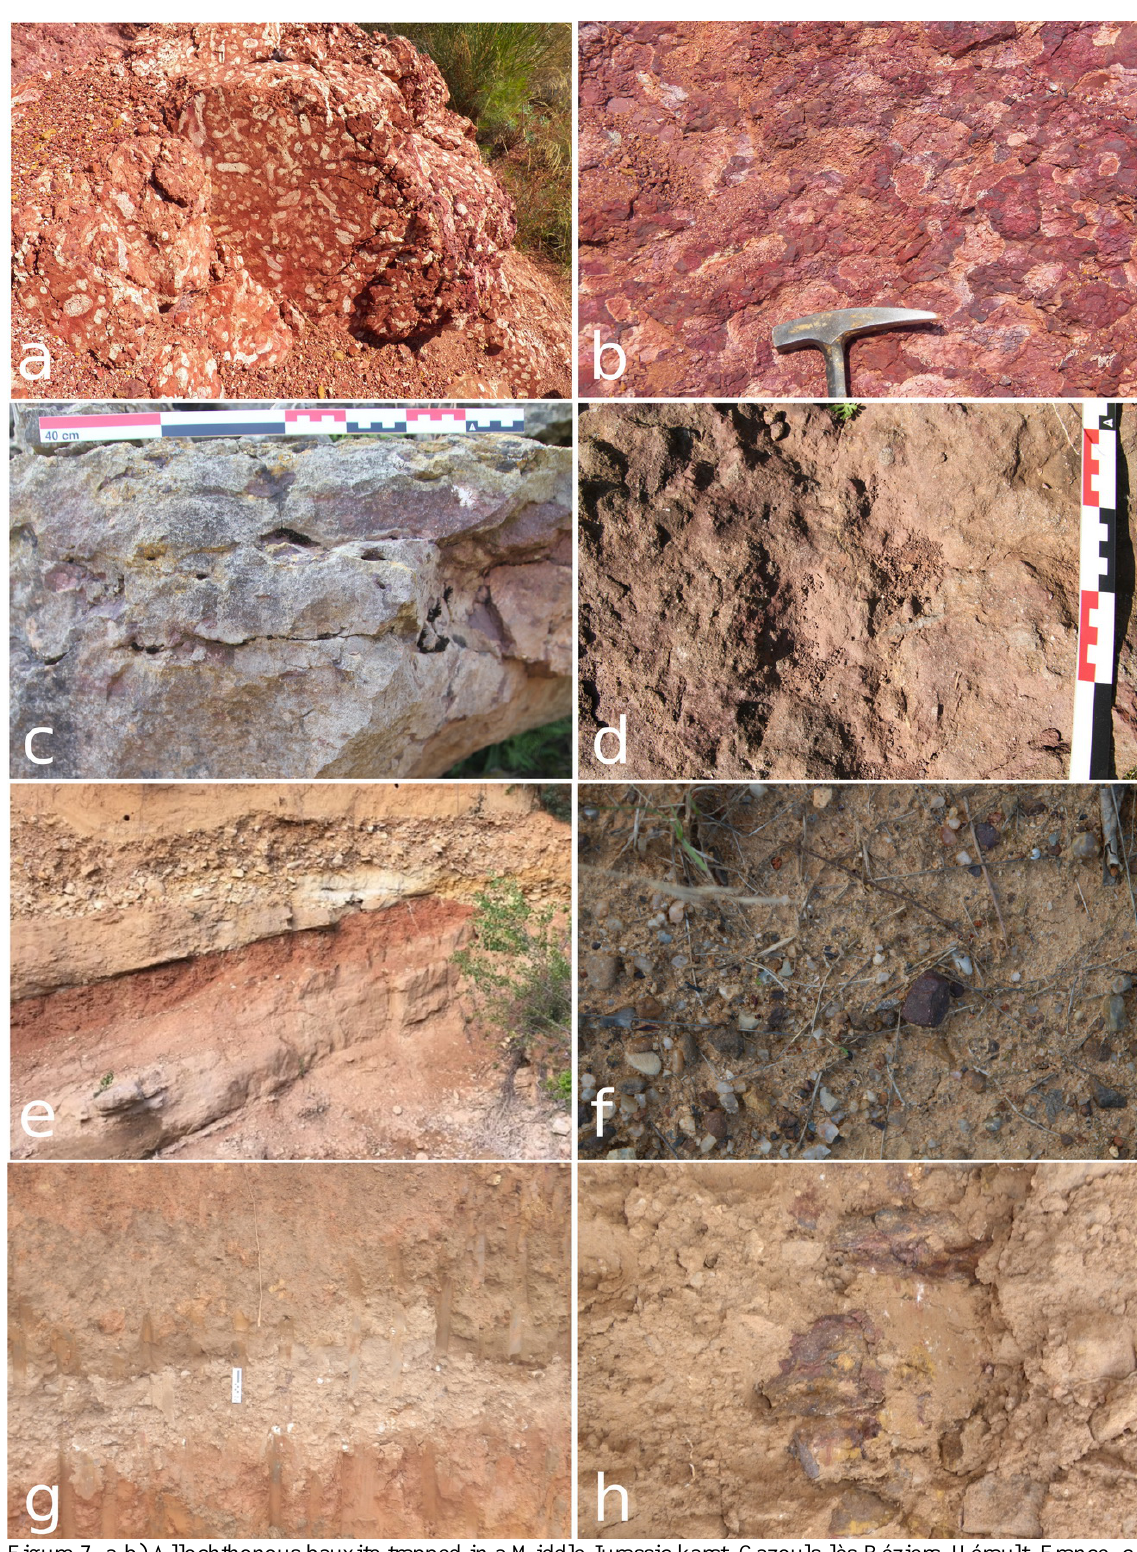
Figure 7. a-b) Allochthonous bauxite trapped in a Middle Jurassic karst, Cazouls-lès-Béziers, Hérault, France, c- d) Ferruginised limestone, Aalenian, La Rousse, Ardèche, France, e-f) Alluvial iron-oxide-rich pebbles in recent and Cretaceous alluviums, Vagnas, Ardèche, France, g-h) Colluvium with fragments of Eocene lateritic crust, Cussac, Périgord, France, g) white scale bar: 20 cm, h) pebbles measures around 5 cm. Photos: H.